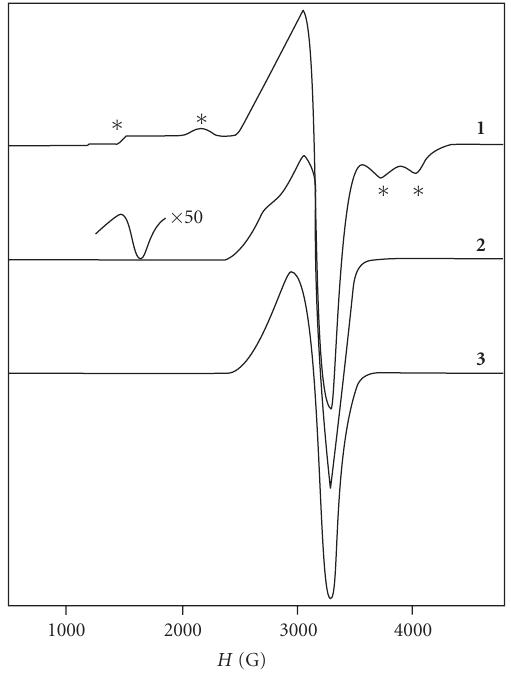
Figure 1: X-band spectrum of compounds 1 , 2 , and 3 . EPR conditions: microwave frequency 9.407 GHz, temperature 4.2K, mod. ampl. 8 Gpp, microwave power 8.2 mW, sweep time 200 seconds, t.c.: 300 milliseconds. The asterisks ( ∗ ) indicate unique peaks characteristic for compound 1 .